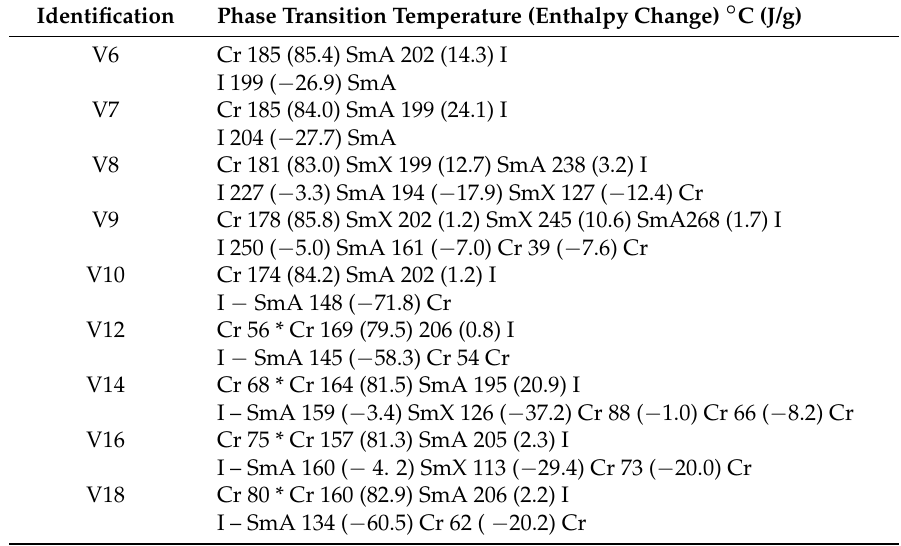
Table 1. Thermodynamic properties of phase transition temperatures of V6–V18 obtained from DSC measurements and POM textures. Phase transition temperatures ( ◦ C) and their enthalpy changes (J/g) were taken at a scanning rate of 10 ◦ C/min from the first heating and cooling